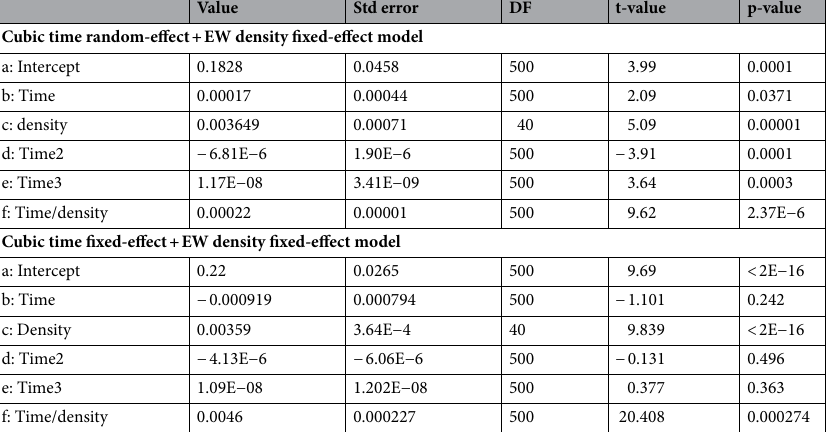
Table 2. The mean value standard error and its statistical significance for the cubic mixed-temporal-effect model + EW density (random temporal effects and fixed EW density effects) and for the cubic fixed-temporal- effect model + EW density. The equation of the model is as follows: Ln (CO 2EW /CO 2CTL ) = a + bxTime + cxEW_ Density + dxTime 2 + exTime 3 + fx(Time/EW_Density).